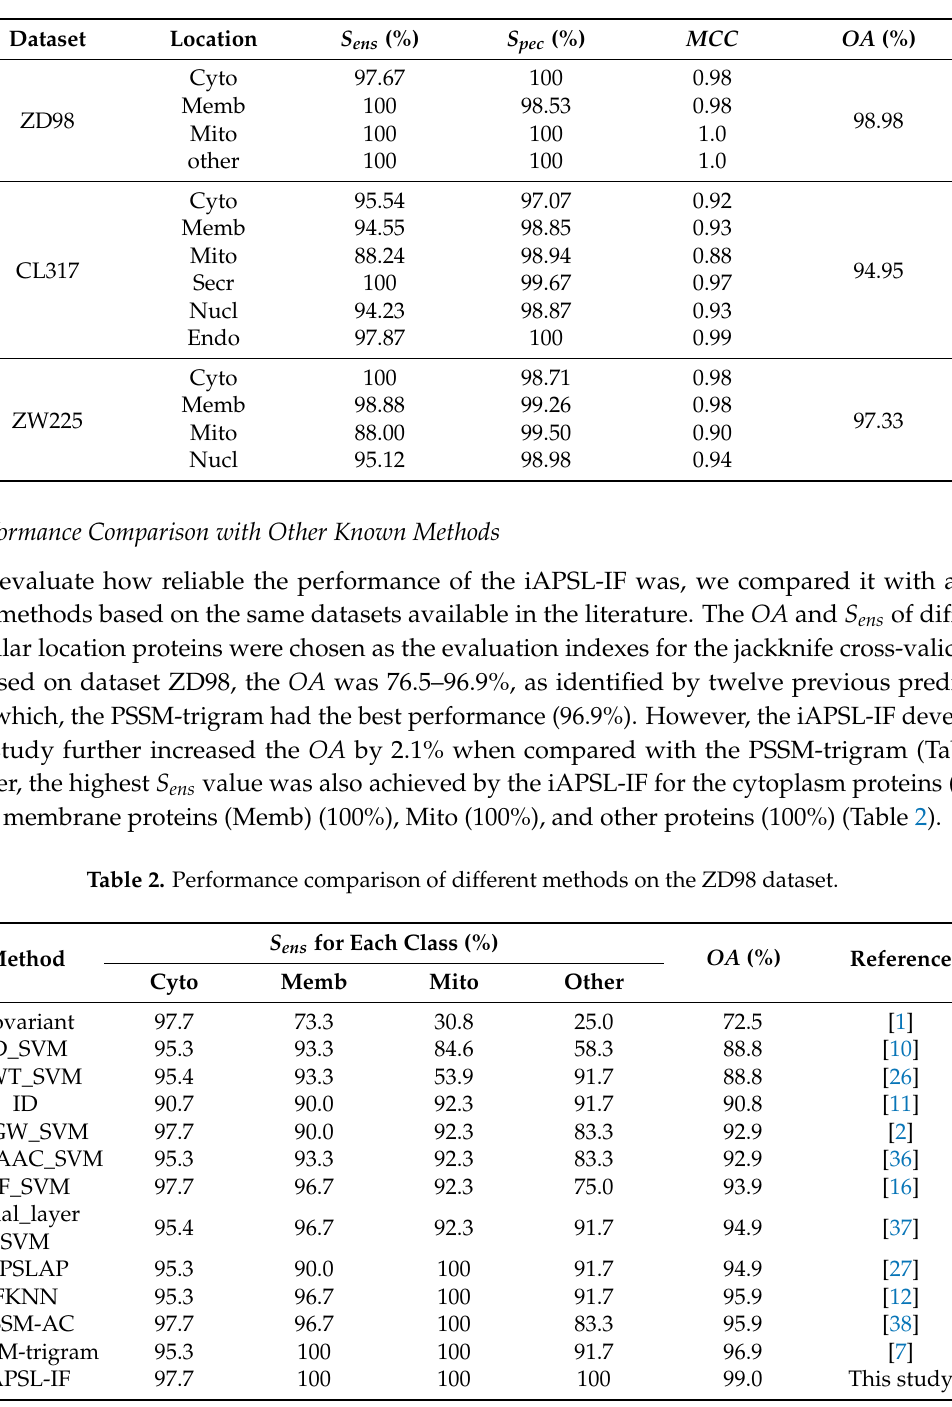
Table 1. Performance of the iAPSL-IF on the three datasets.